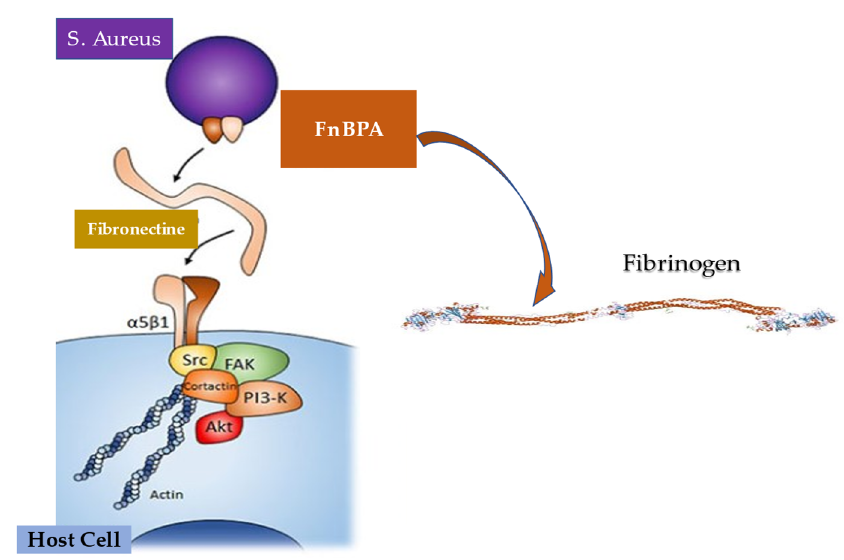
Figure 10. Experimental endocarditis induced by S. aureus marked the crucial function of sequential fibrinogen binding responsible for valve colonization and the paramount action of fibronectin binding leading to endothelial invasion. FnBPA responsible for fibrinogen and fibronectin binding may promote cell invasion in vivo endocarditis.